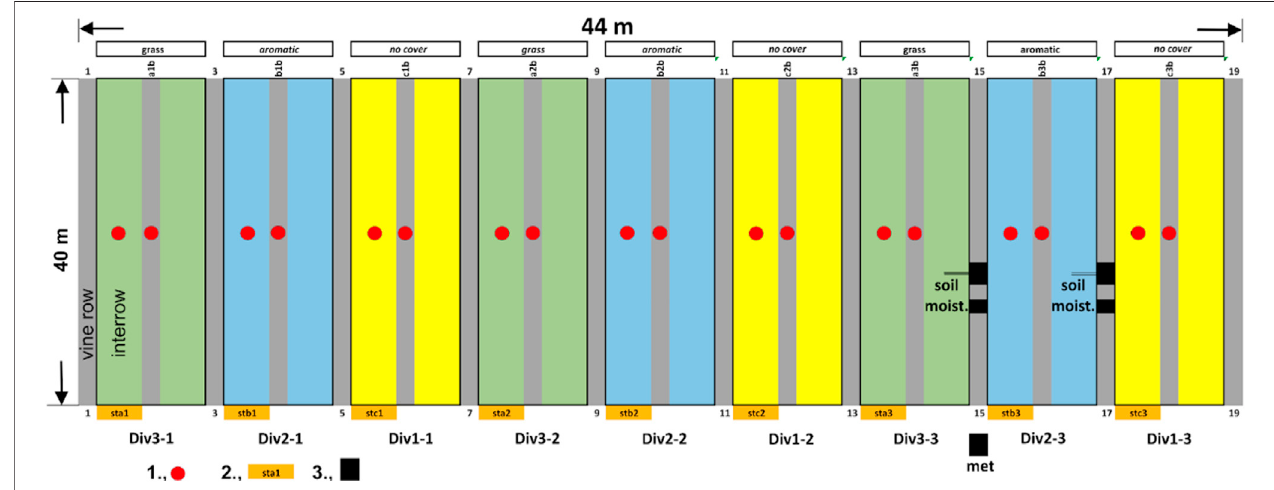
FIGURE 5 | Villány CS11 diversi fi cations: green: grass; blue: aromatic herb ( Achillea millefolium ); yellow: uncovered; 1: chambers; 2 sediment traps; 3: stations for environmental parameters (d).